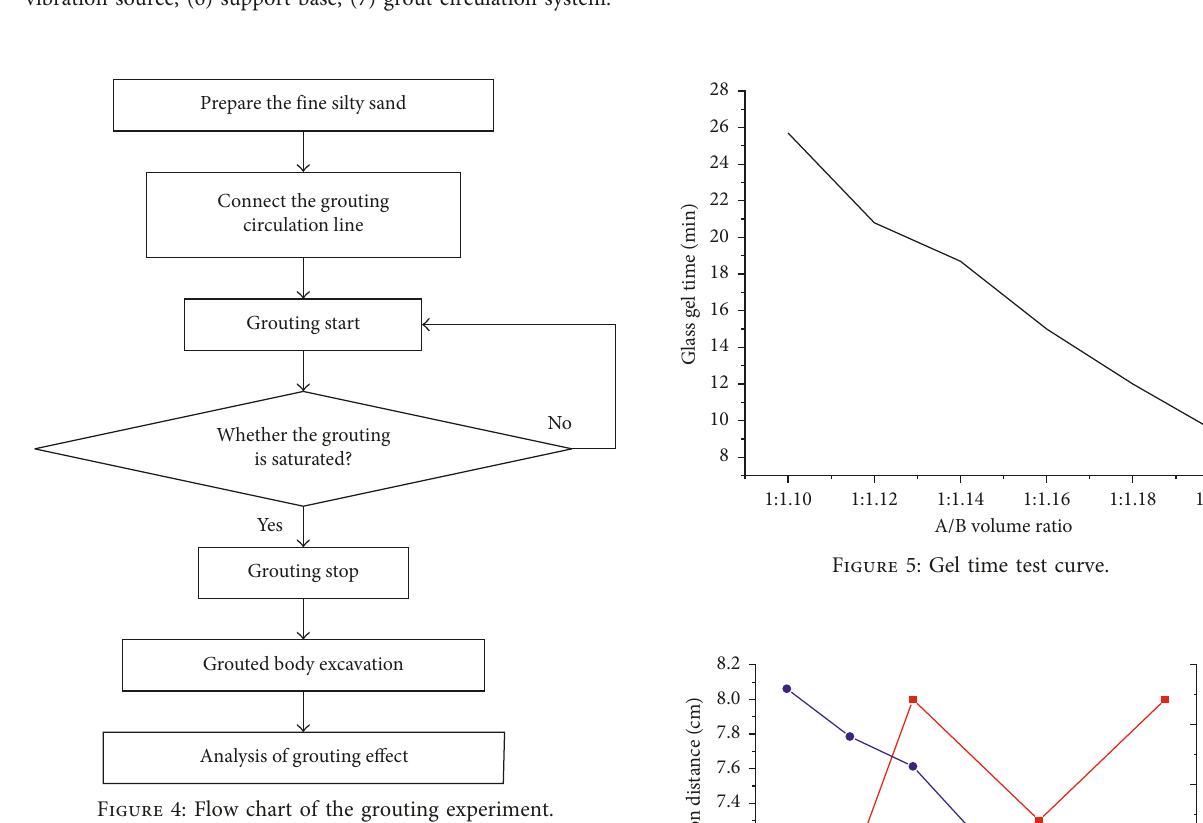
Figure 3: Grouting experimental device. (1) Sand storage box; (2) grouting concretions; (3) fine silty sand; (4) grouting drilling tools; (5) vibration source; (6) support base; (7) grout circulation system.